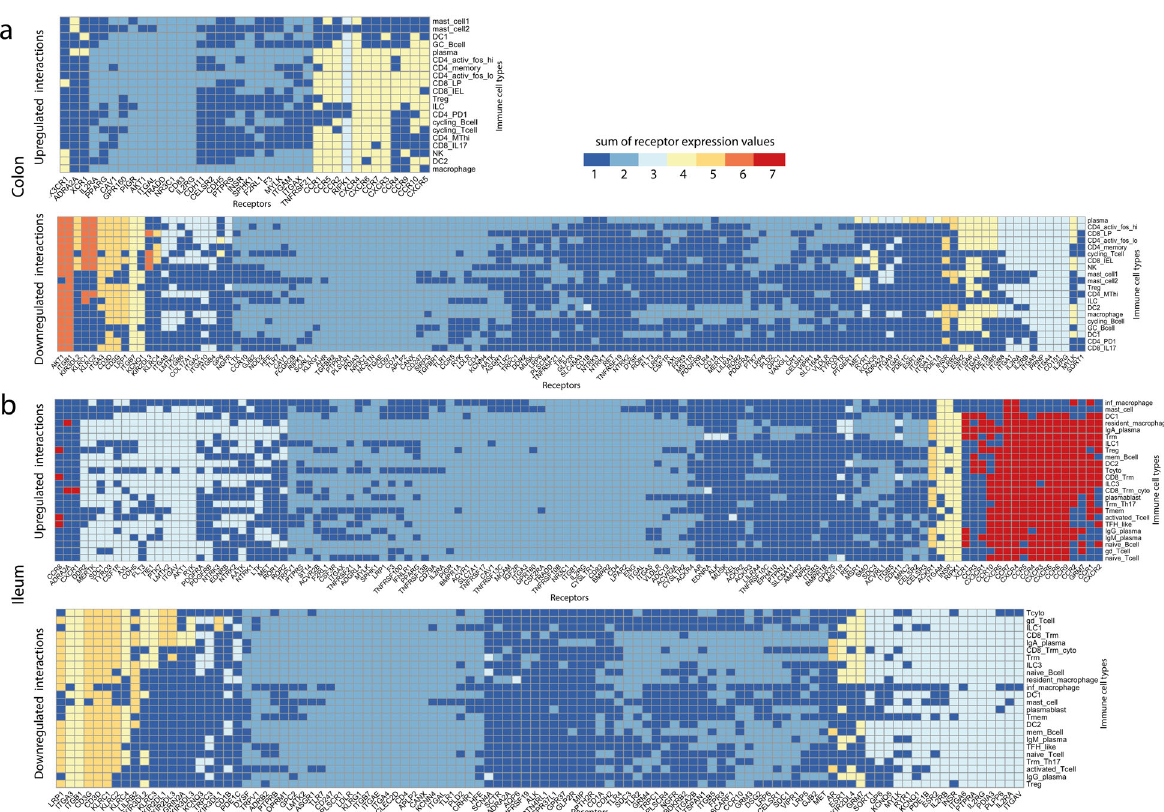
Fig. 8 Receptors on immune cell types involved in the strongest up and downregulated interactions upon SARS-CoV-2 infection in the colon and ileum. a , b Heatmap showing the upregulated and downregulated interactions in the colon ( a ) and ileum ( b ) between receptors and resident immune cell types upon infection of immature enterocytes with SARS-CoV-2. The number of interactions in which each receiving receptor on immune cell types is involved is visualised using a colour gradient from blue (weakest interactions) to red (strongest interactions). Abbreviations: Ileum : inf_macrophage infected macrophage, mast mast cell, CD8_Trm_cyto Resident memory cytotoxic T cell, DC2 dendritic cell 2, Trm Tissue-resident memory T cell, gd_Tcell Gamma delta ( γδ ) T cells, ILC Innate lymphoid cell, mem_Bcell memory B cell,